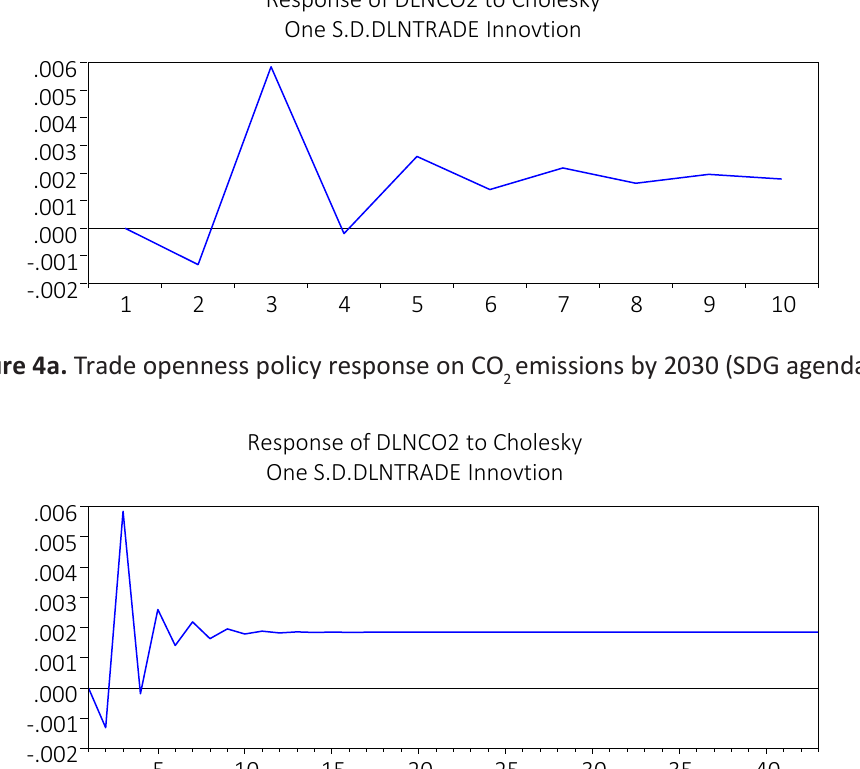
Figure 4b. Trade openness policy response on CO